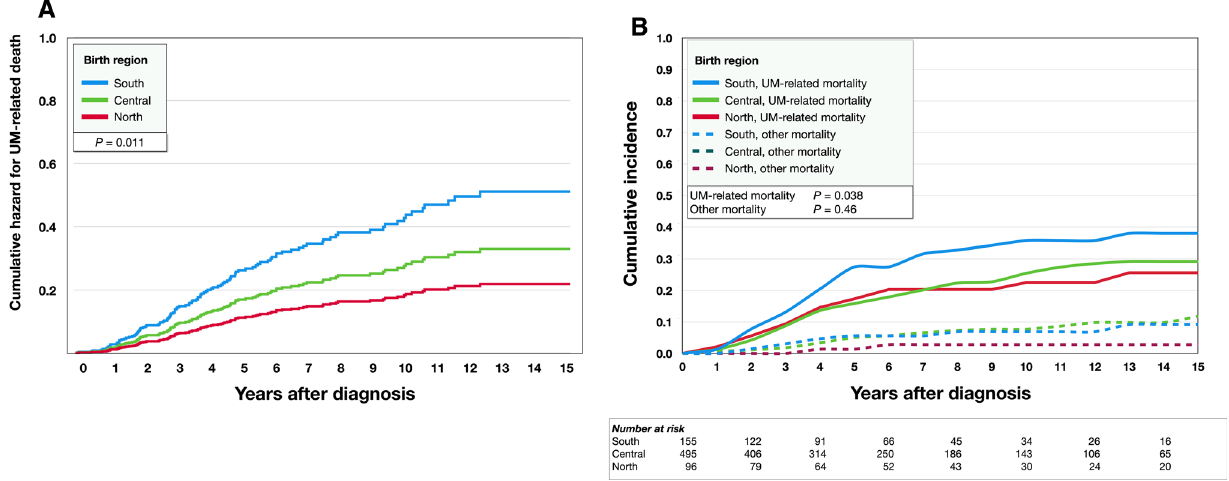
Fig. 2 Survival curves. A Cumulative Cox regression hazard for uveal melanoma (UM)-related death across the southern, central, and north- ern regions. Adjusted for patient age at diagnosis, tumor diameter and tumor thickness. B Cumulative incidence of UM-related mortality and mortality from other causes. UM, uveal